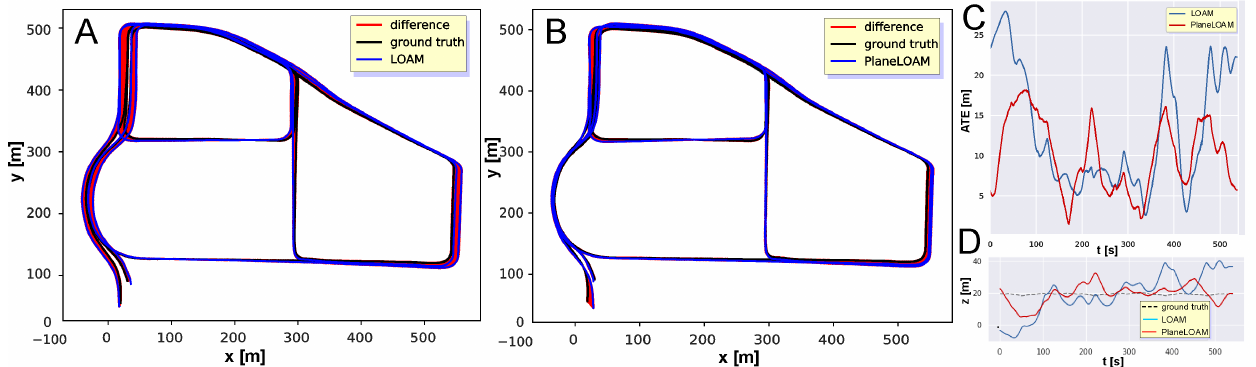
Figure 16. Absolute trajectory errors for the MulRan DCC sequence acquired with an Ouster OS1-64 LiDAR. This long sequence contains multiple loops, but the results of PlaneLOAM ( A ) and LOAM ( B ) estimation were obtained without any loop detection and closing. The plot of the ATE values vs. time ( C ) shows that PlaneLOAM keeps the overall pose error smaller than LOAM for most of the trajectory, and in particular it yields better estimates of the elevation values ( D